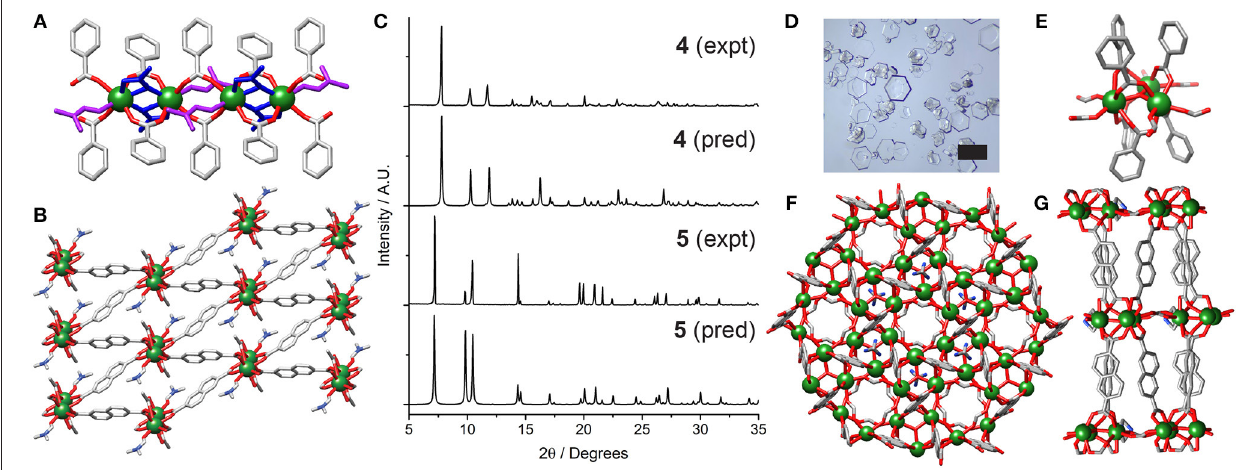
FIGURE 4 | Crystal structure of 4 . (A) One dimensional chain SBU, with coordinated acetate (blue) and DMF (magenta). (B) Packing structure viewed down the b axis. (C) Stacked PXRD patterns of 4 and 5 compared to their predicted patterns. (D) Optical image of the hexagonal plates of 5 , which give rise to preferred orientation related peak height discrepancies in the PXRD pattern of bulk samples. Scale bar 500 µ m. Crystal structure of 5 . (E) Trigonal SBU showing bridging formates. (F) Packing structure showing solvent inaccessible voids between SBUs. (G) Hexagonal packing arrangement viewed down the c axis.